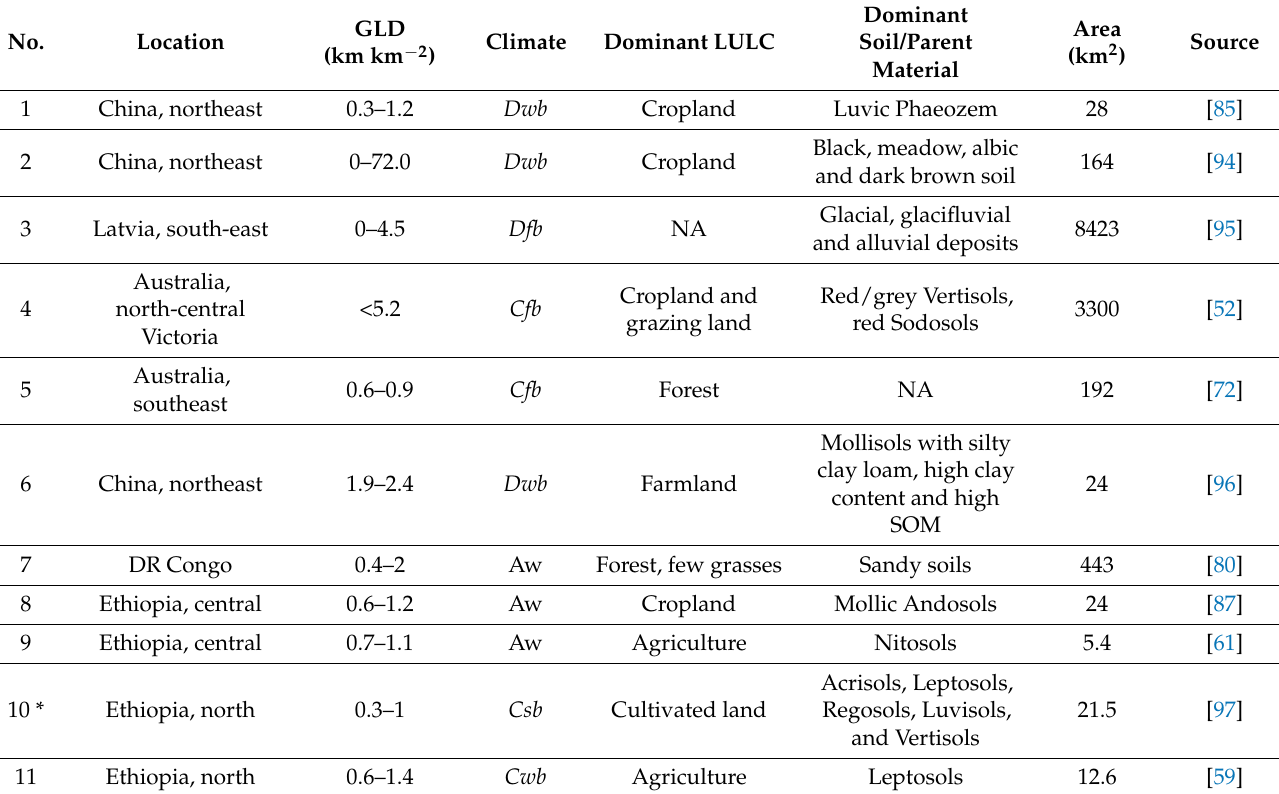
Table A1. Overview of GLD reported for different